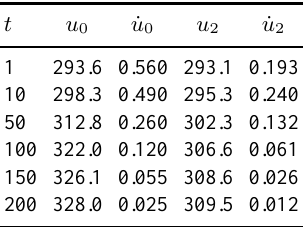
Table 4. The values u 0 = u 1 ; u 2 ; _ u 0 ; _ u 2 in time t without